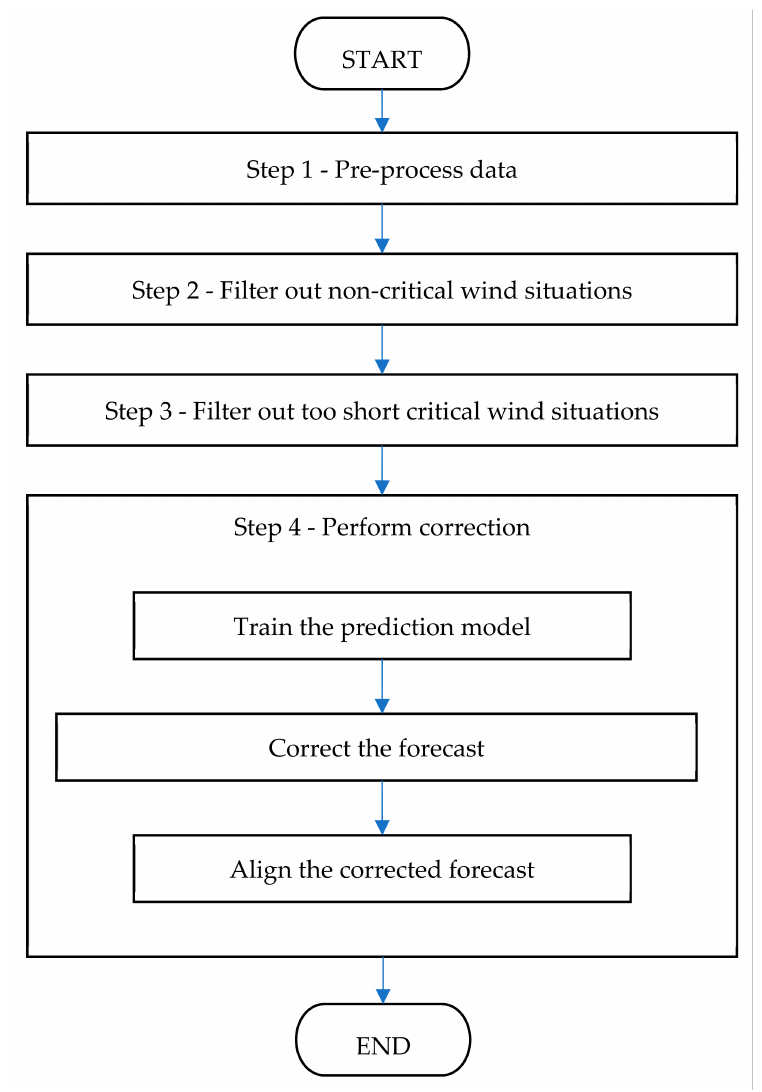
Figure 2. Steps of the FOCUSED